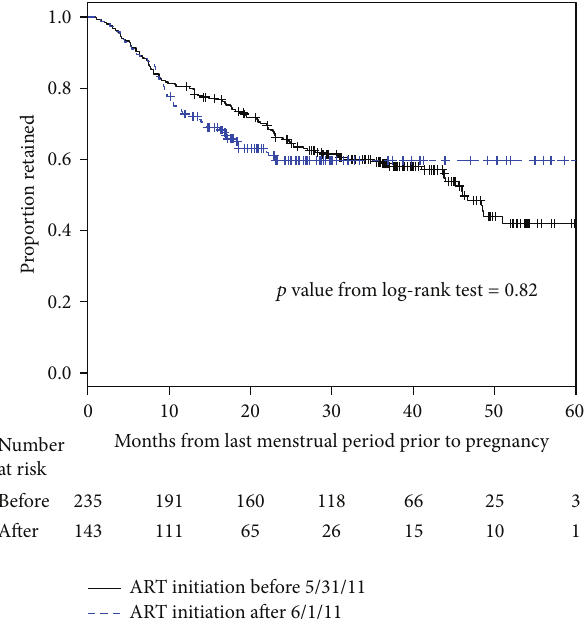
Figure 3: Retention in care by cohort number based on ART initiation